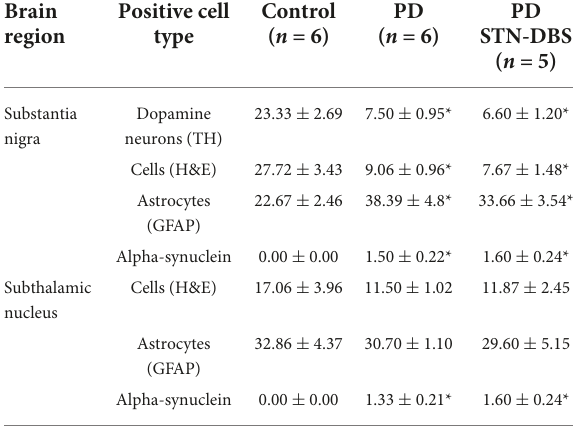
TABLE 2 Means and SEM of cellular analysis in substantia nigra (SN) and subthalamic nucleus (STN). Brain region